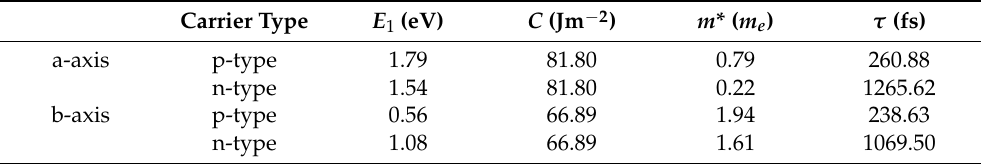
Figure 5. The calculated Seebeck coefficient ( S ) ( a , b ) and electrical conductivity ( σ ) ( c , d ) of the mon- olayer Hf 2 Br 4 at various temperatures (300, 500, and 700 K, respectively). Table 1. The calculated deformation potential constant E 1 , elastic constant C and effective mass m * ( m e is the electronic mass) for Hf 2 Br 4 . The relaxation time τ at 300 K is listed together.